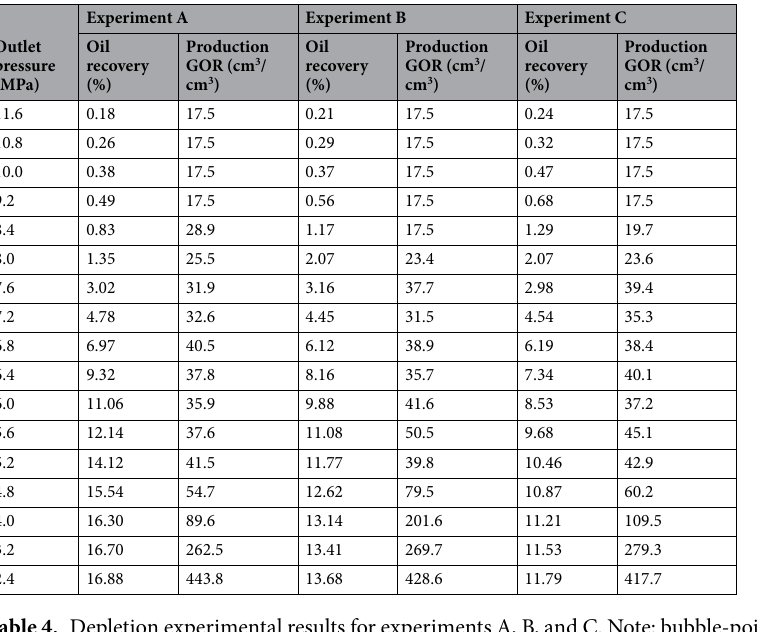
Table 4. Depletion experimental results for experiments A, B, and C. Note: bubble-point pressure for both oil samples is 8.45 MPa, and pseudo-bubble-point pressures for experiment A, B, and C are 4.68 MPa, 4.92 MPa, and 5.01